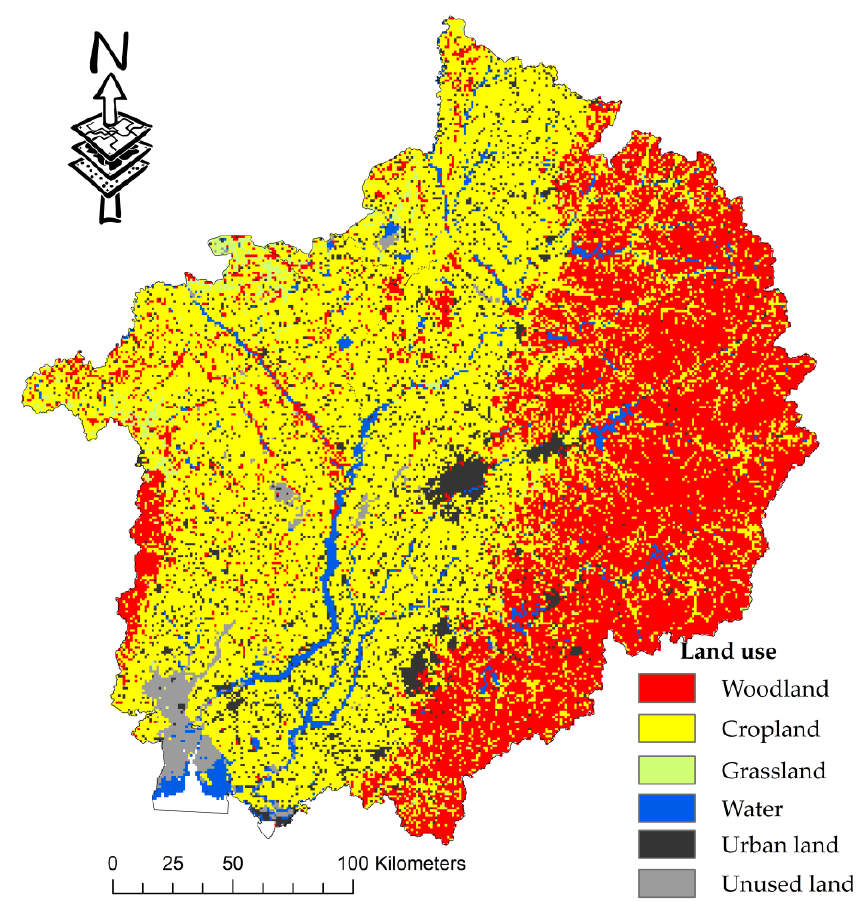
Figure A1. Land use map of the study area. Note: the data set was provided by Data Center for Resources and Environmental Sciences, Chinese Academy of Sciences (RESDC).